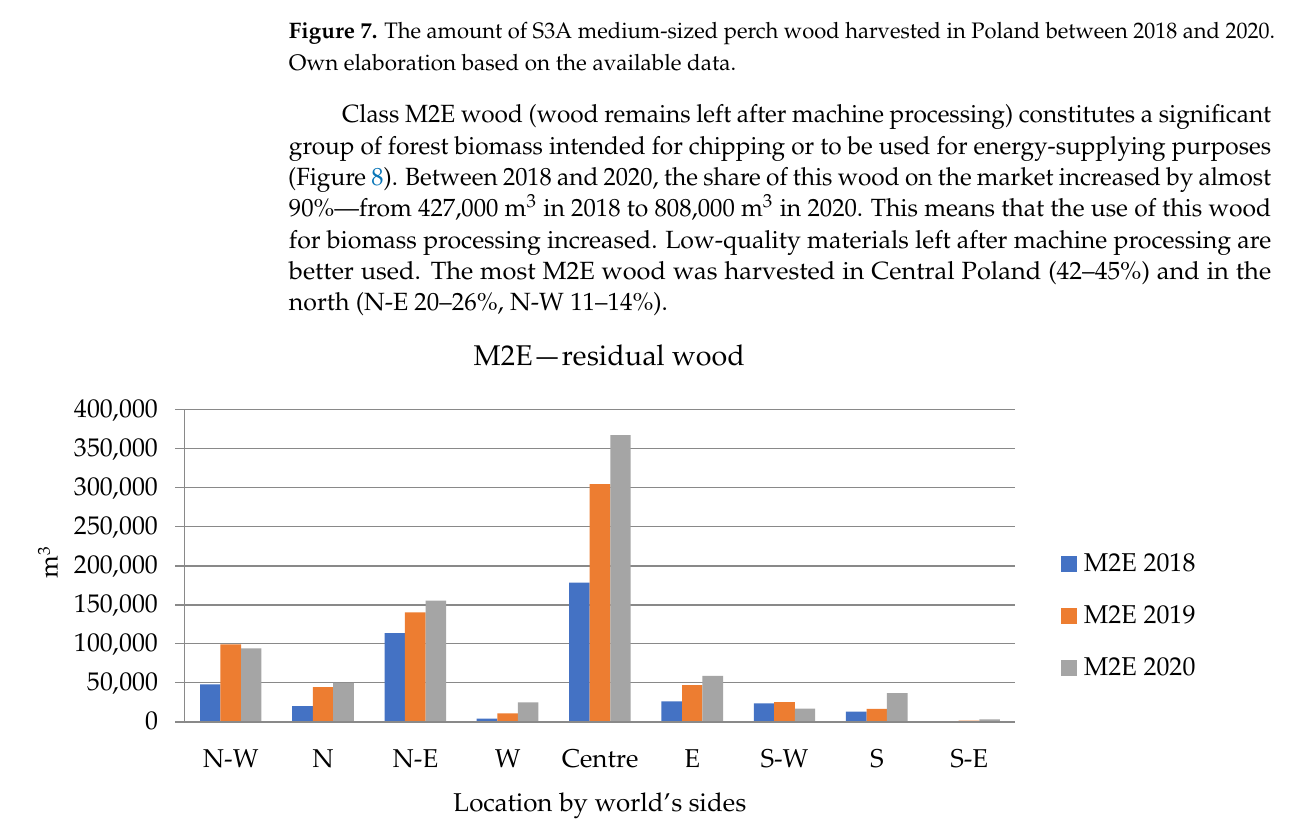
Figure 8. The amount of M2E wood remains harvested in Poland between 2018 and 2020. Own elaboration based on the available data.